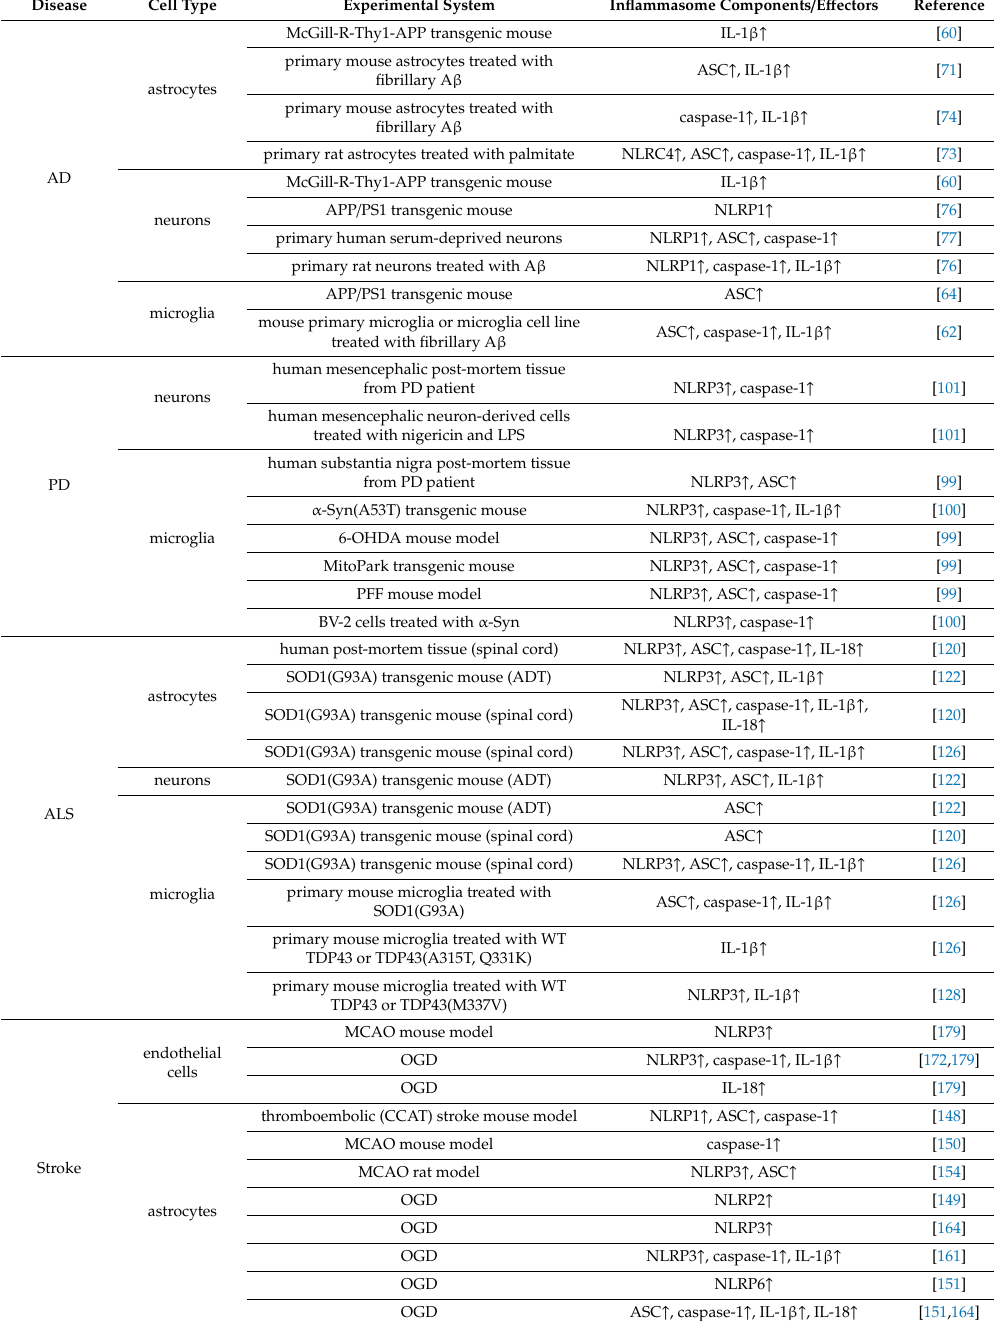
Table 1. Changes in levels of inflammasome components and e ff ectors in cells of the NVU in age-related